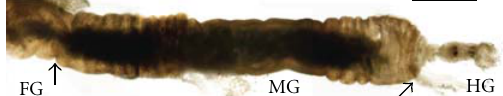
Figure 2: Photomontage of a whole mount of the foregut (FG), midgut (MG), and hindgut (HG) of a balsam fir sawfly larva. The arrow on the left indicates the junction of the foregut and midgut and the arrow on the right indicates the junction of the midgut and hindgut, where the Malpighian tubules (to the right of the arrow) are inserted. Scale bar = 2mm.